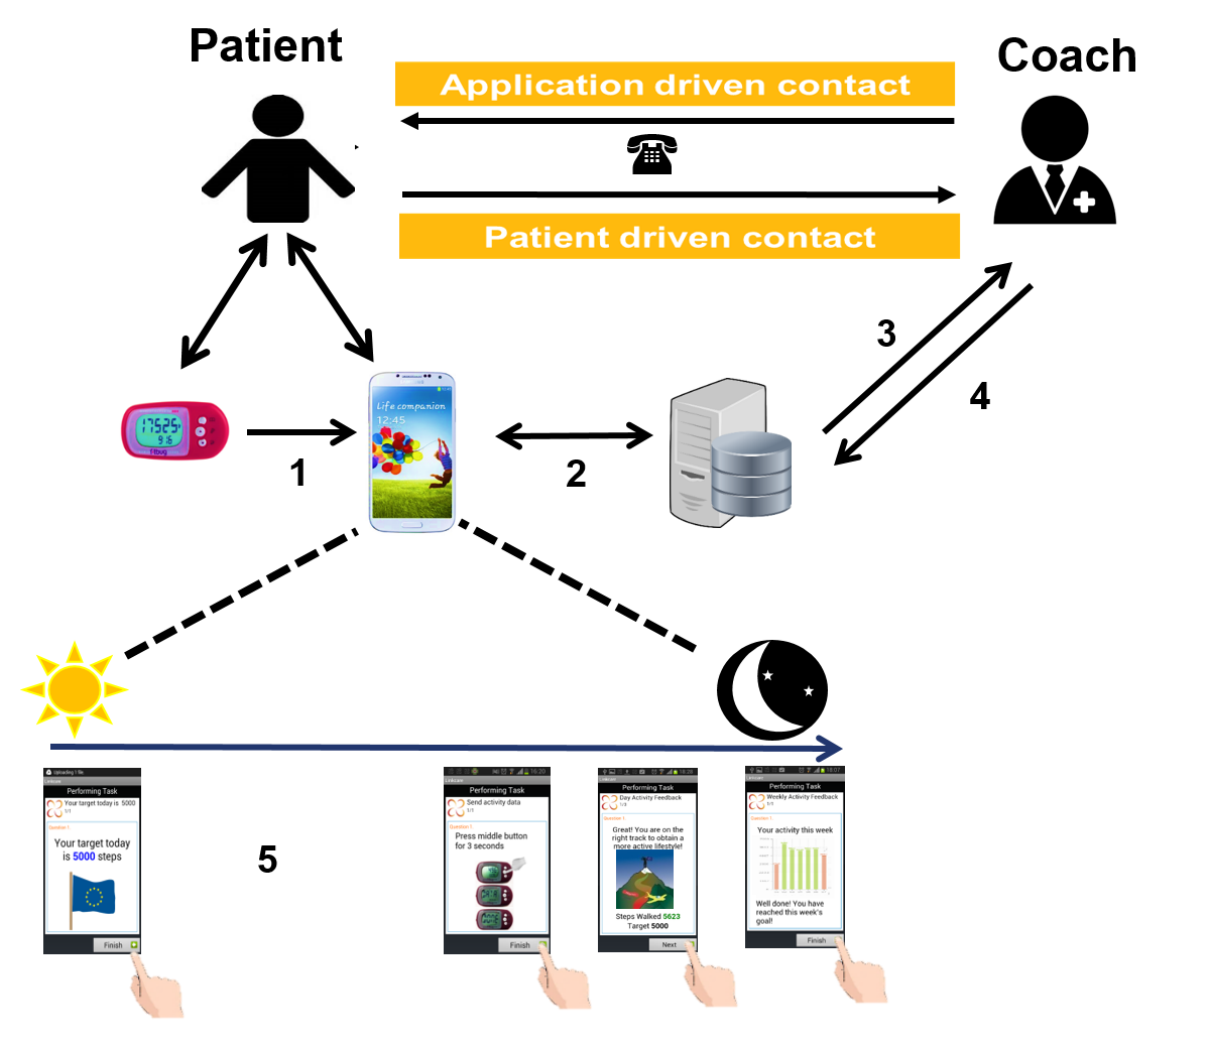
Figure 1. Overview of the intervention; 1=sending of “steps data” to smartphone (through Bluetooth); 2=data sent to central database; 3=coach is able to access database; 4=coach is able to manually adjust goals, 5=accessing & closing the different tasks on the smartphone app (automated messages); i.e., (from left to right); morning goal, send activity in the evening, daily feedback (from Monday to Saturday) and weekly feedback (only on Sunday)